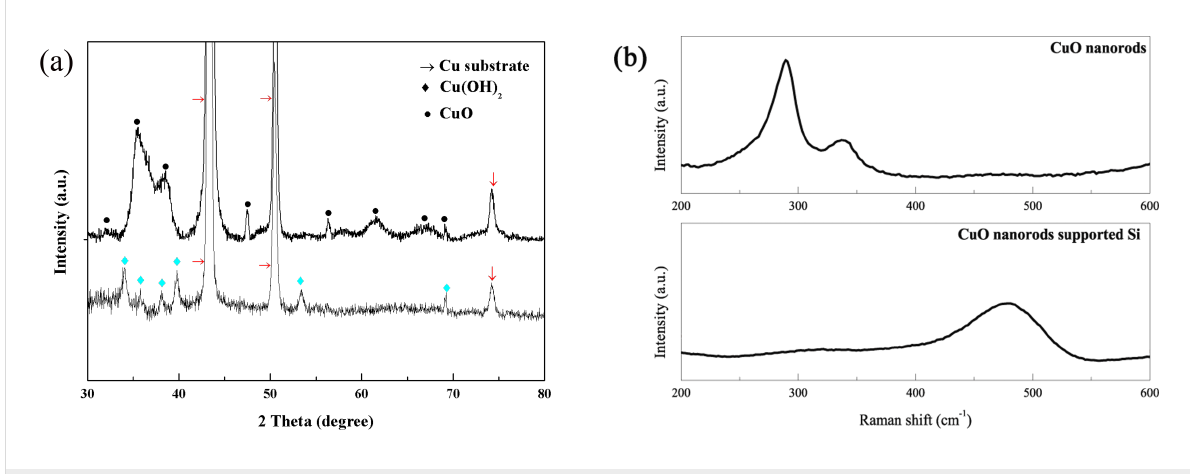
Figure 1: (a) X-ray diffraction patterns of the as-prepared Cu(OH) 2 and CuO nanorods; (b) Raman spectra of the CuO nanorods and Si-coated CuO nanorods.